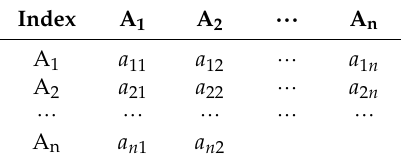
Table 2. Comparison judgment